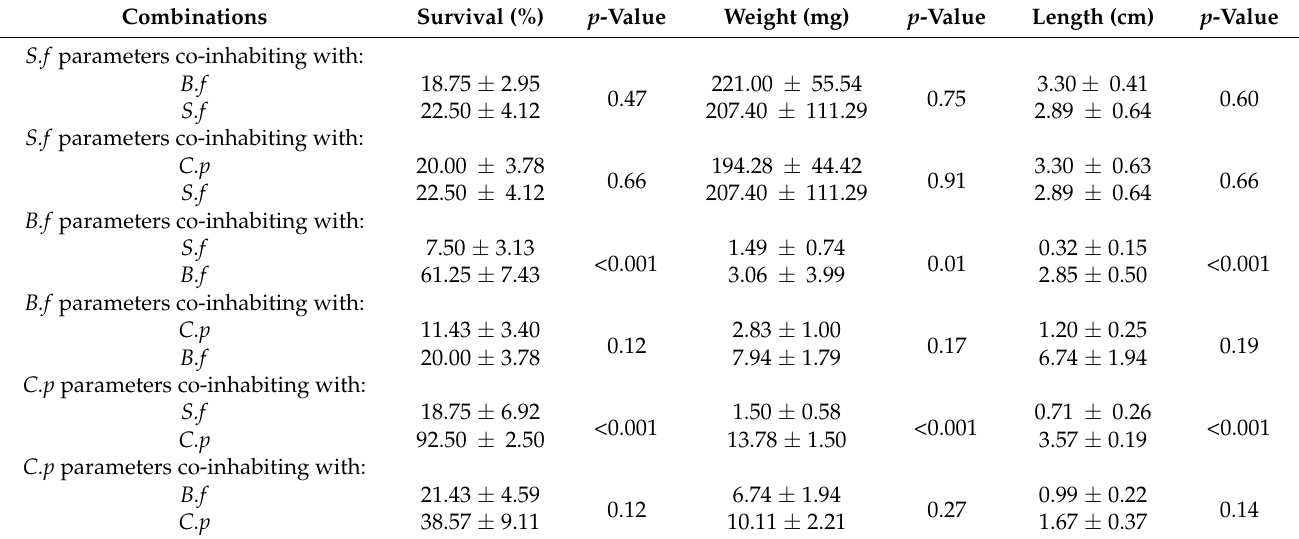
Table 1. Percentage survival, mean larval weight, length and frequent instar when Spodoptera frugiperda, Busseola fusca , and Chilo partellus co-existed together on maize whorls for 15 days in